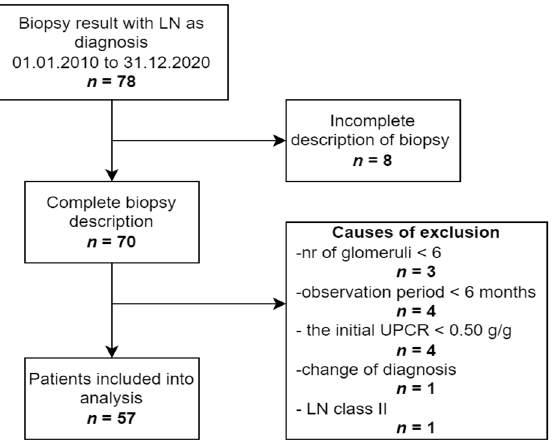
Figure 1. The process of patients’ selection. Abbreviations: LN, lupus nephritis; n, number of patients; UPCR, urine protein-to-creatinine ratio.